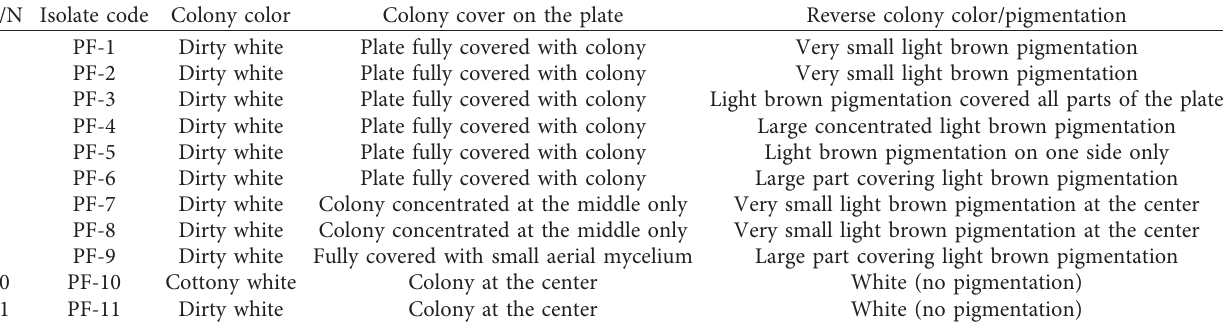
Table 1: Morphological characterization of isolated